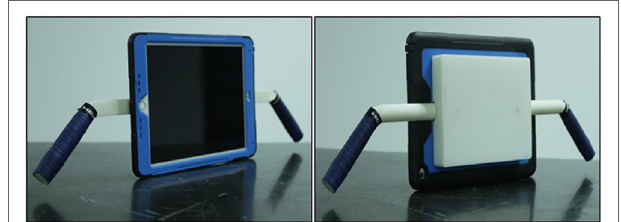
FigUre 8 | The light weight, high density bi-handled casing support pieces were created using a 3D printer and then affixed to a commercially available iPad case. This adapted casing facilitates active exercise while simultaneously protecting the